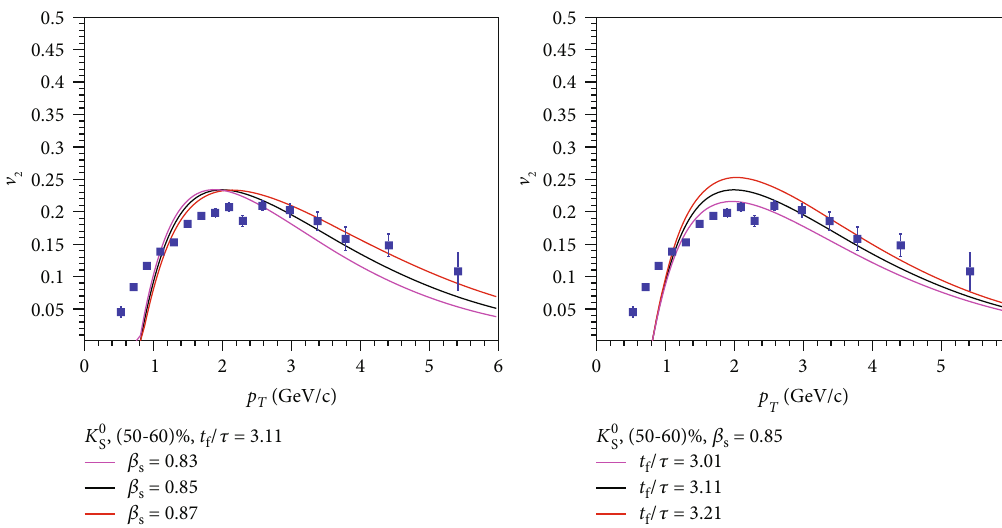
ffiffiffiffiffiffiffiffi p = 2 : 76 TeV . Symbols are s NN